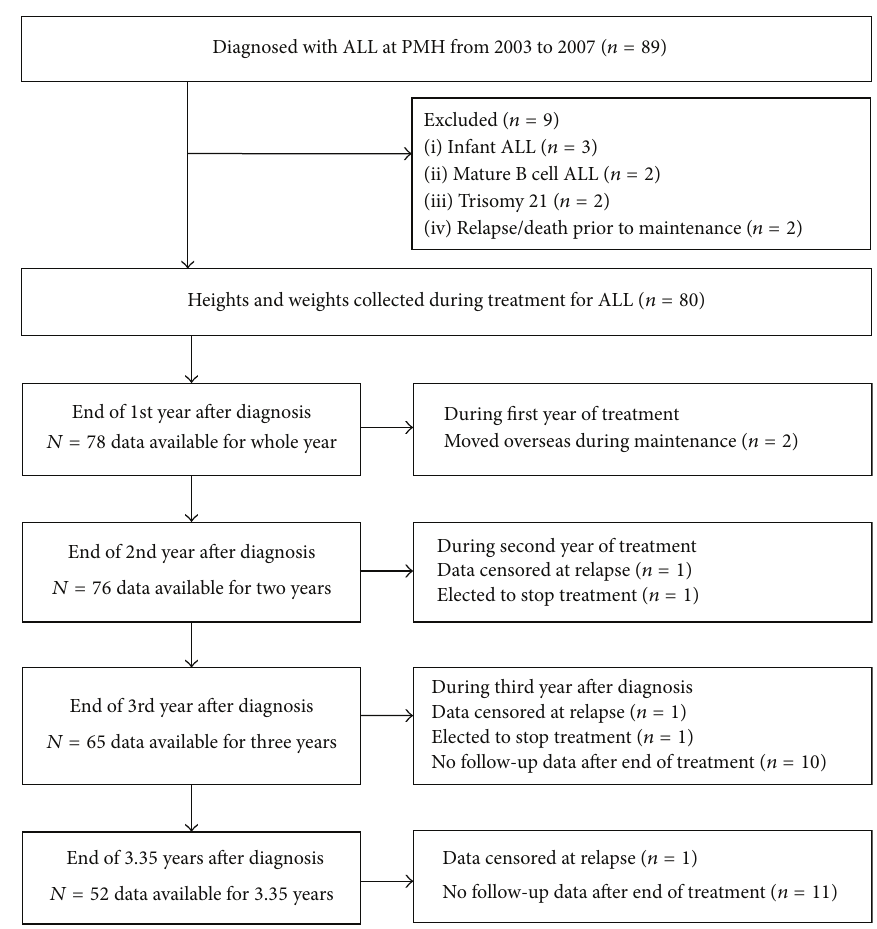
Figure 1: Flow diagram of patients and data included in this